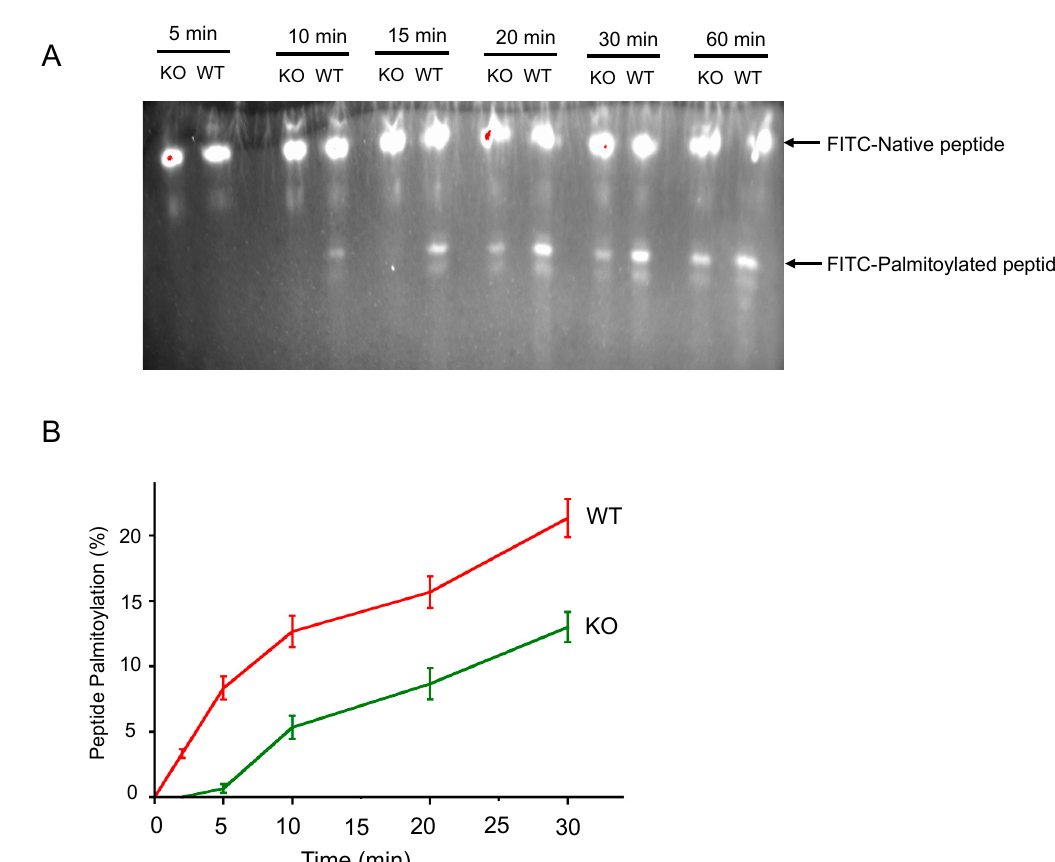
microsomes were prepared containing ER membranes with or without SELENOK, respectively. Substrates including palmitoyl-CoA and FITC-peptide were added to microsomes for different periods of time after which the reaction mixtures were subjected to reverse-phase TLC. Fluorescent bands corresponding to palmitoylated peptides were identified using UV transillumination. ( B ) For each experiment, equivalent levels of DHHC6 were confirmed using Western blotting.